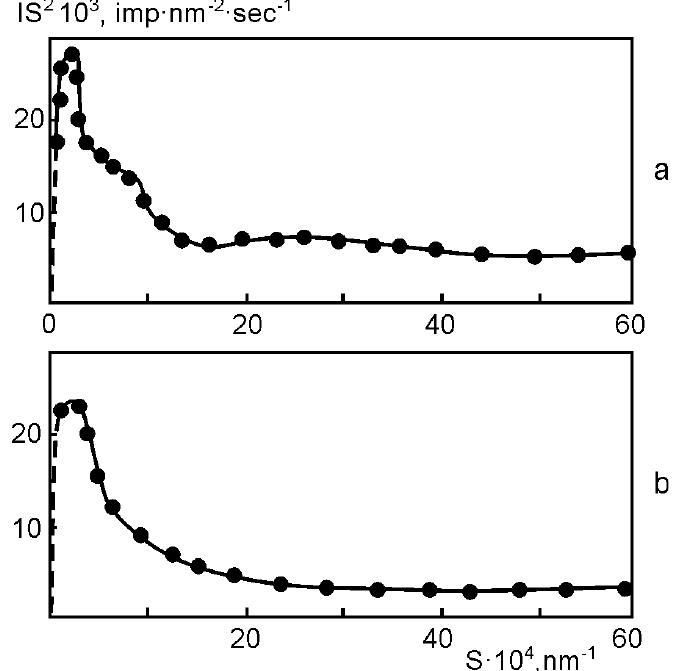
Figure 2. SAXS indicatrix invariant for Cu coatings precipitated under Earth-based ( a ) and space ( b )